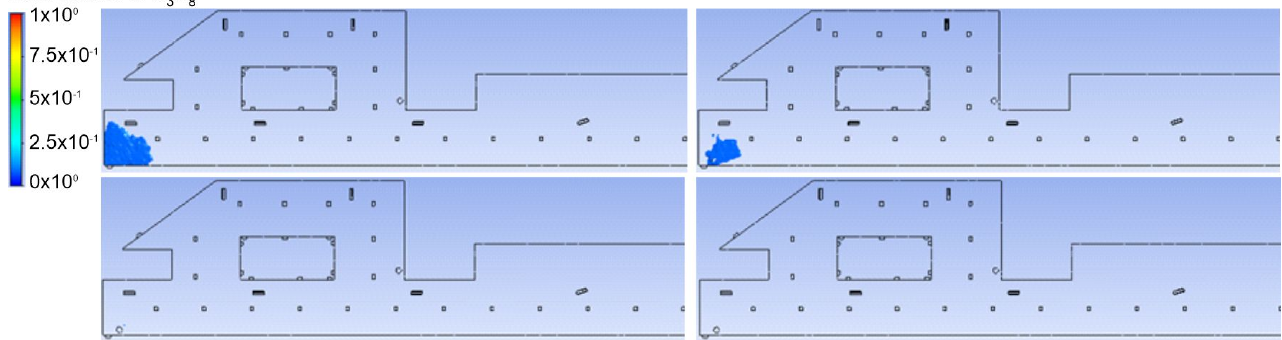
Figure 11. Upper explosive limit of LPG dispersion for A source for different time steps of 15 s, 35 s, 55 s and 70 s.